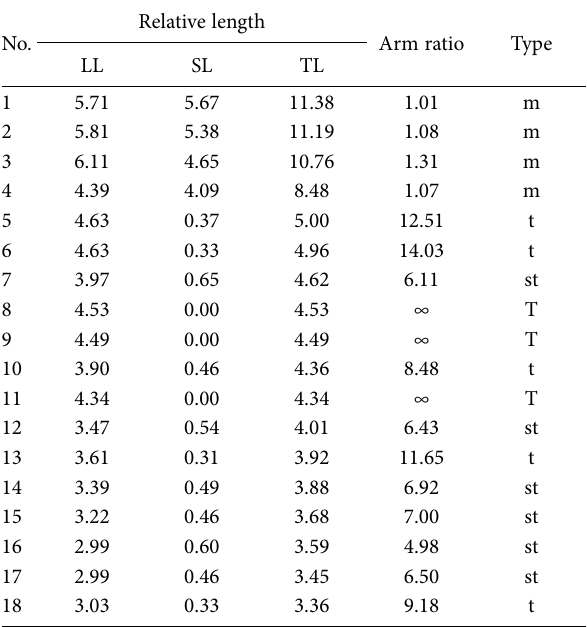
Table 2. Measurements of somatic chromosomes of the putative natural hybrid .